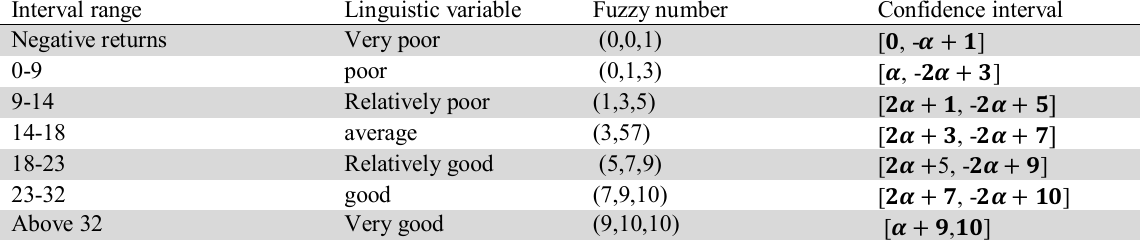
Linguistic Variables and their Corresponding Fuzzy